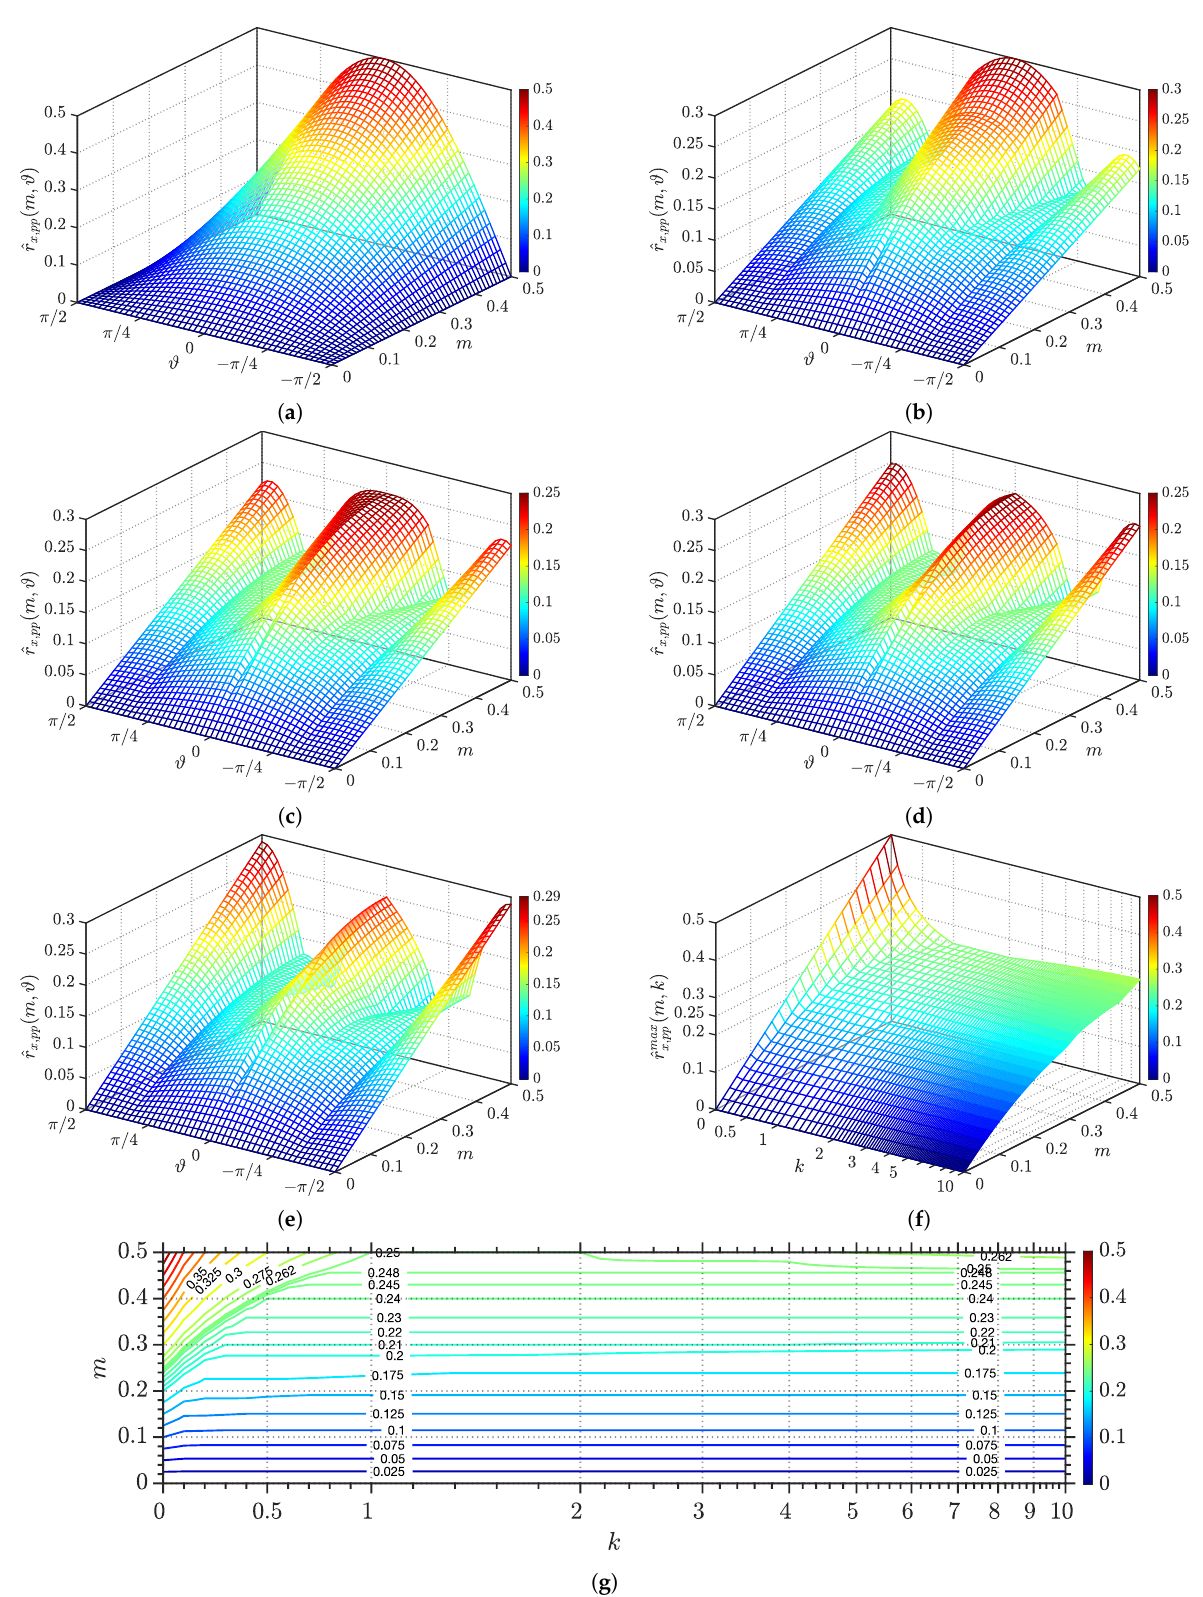
Figure 6. Maximum profiles of normalized peak-to-peak primary and secondary phase switching current ripple envelopes in the case of SPWM: ( a ) k = 0, ( b ) k = 0.5, ( c ) k = 1, ( d ) k = 2, and ( e ) k = ∞ ; maximum normalized peak-to-peak phase switching current ripple as a function of modulating index m and k factor ( f , g ).